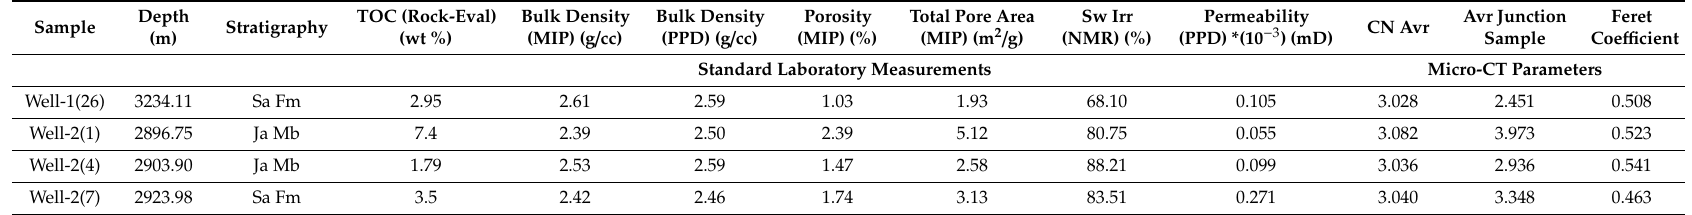
Table 3. Petrophysical parameters of the samples selected for the micro-CT measurements and other laboratory experiments. Symbols: CN avr